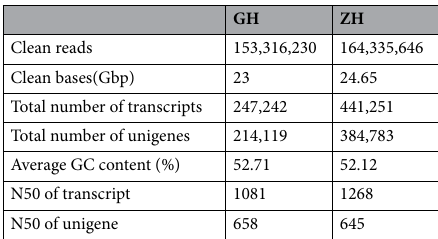
Table 1. Summary of the transcriptome of Asian Badgers and Northern Hog Badgers.